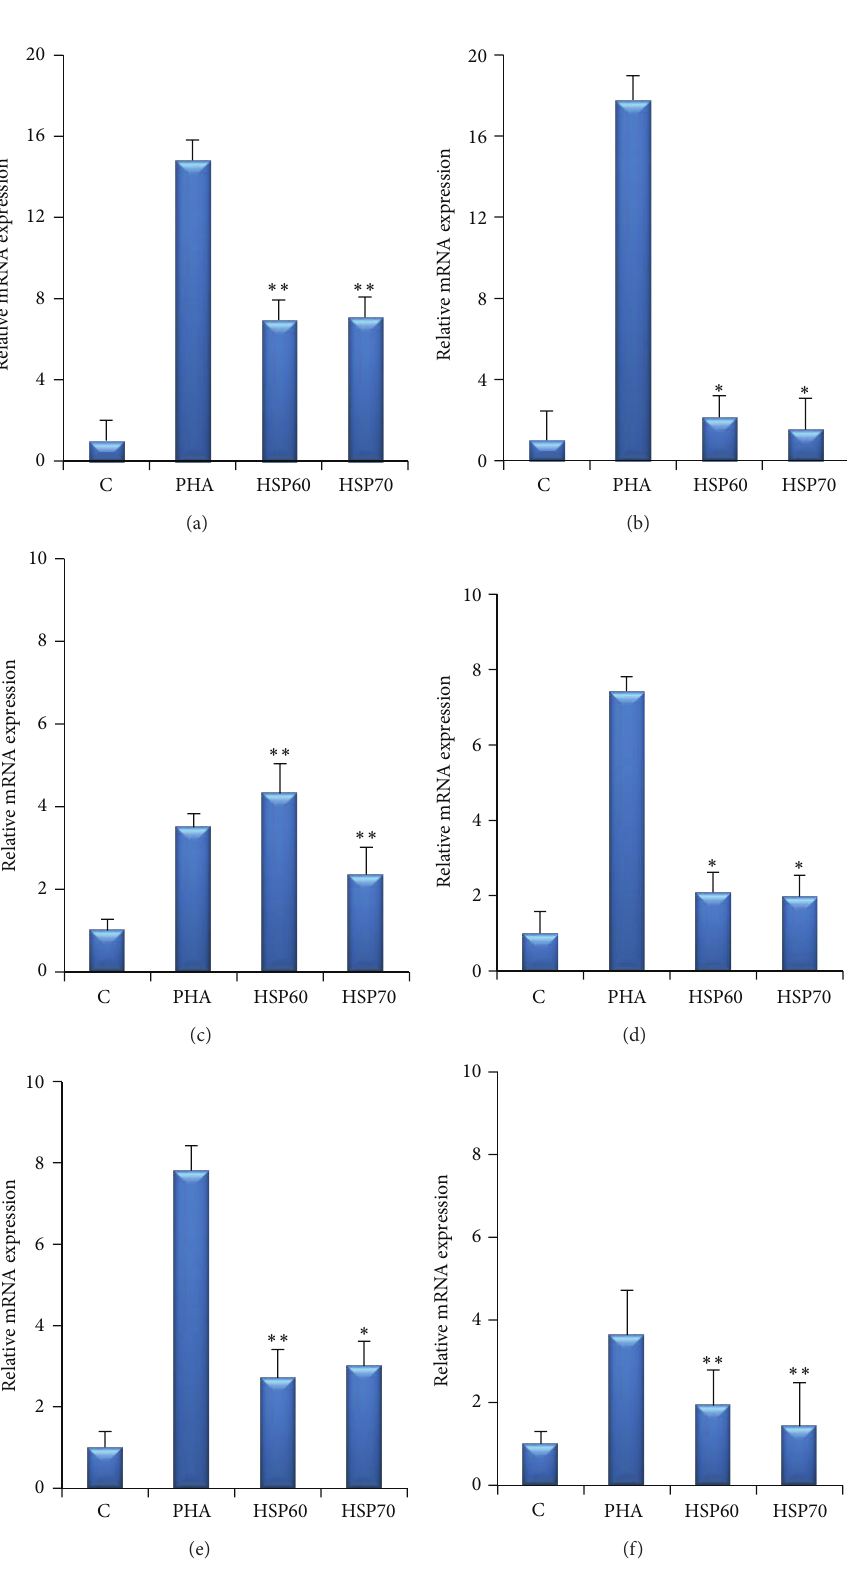
Figure 3: Relative mRNA expression of IFN- 𝛾 , perforin, and granzyme B in CD4 + CD2 8 null cells ((a), (c), (e)) as well as in CD4 + CD28 + cells ((b), (d), (f)) in CKD subjects. 48hr of stimulation of HSP60 (5 ng/mL) and HSP70 (5ng/mL) increased the expression of IFN- 𝛾 , perforin, and granzyme B in both T-cell subsets compared to unstimulated controls. PHA (10 𝜇 g/mL) served as a positive control for both T-cell subsets. ∗∗ 𝑃 < 0.0001 , ∗ 𝑃 < 0.001